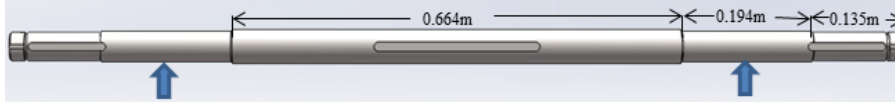
Figure 5. Three-dimensional structure and parameters of main shaft.